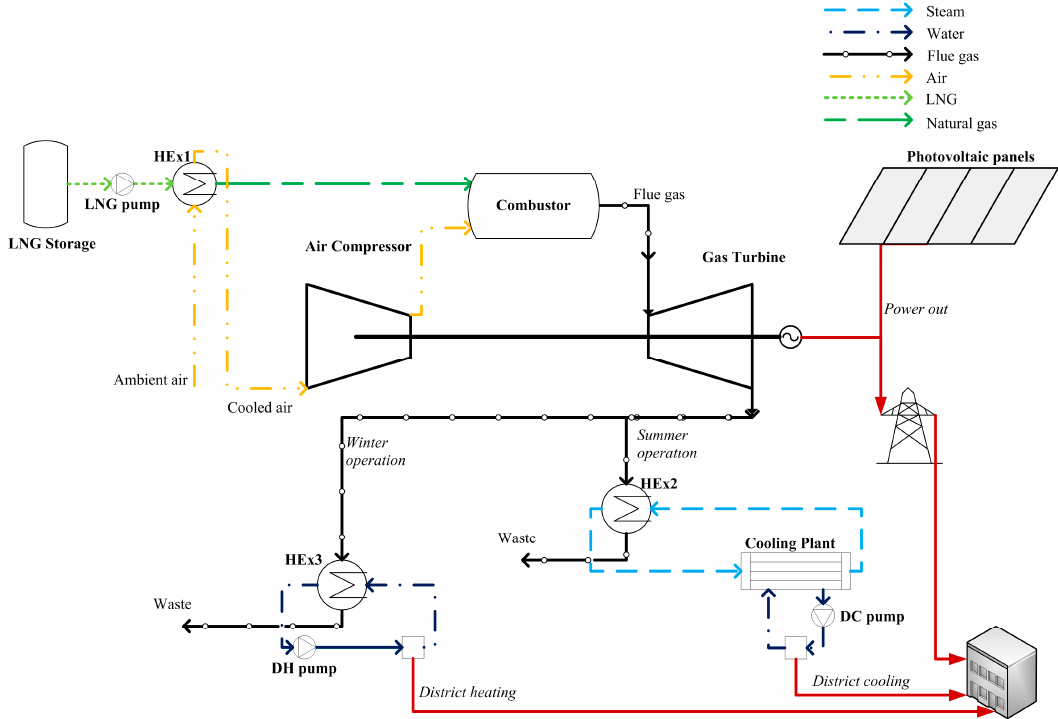
Figure 1. Schematic configuration of the proposed photovoltaic (PV)-assisted 1 MW e combined cooling, heating, and power system.